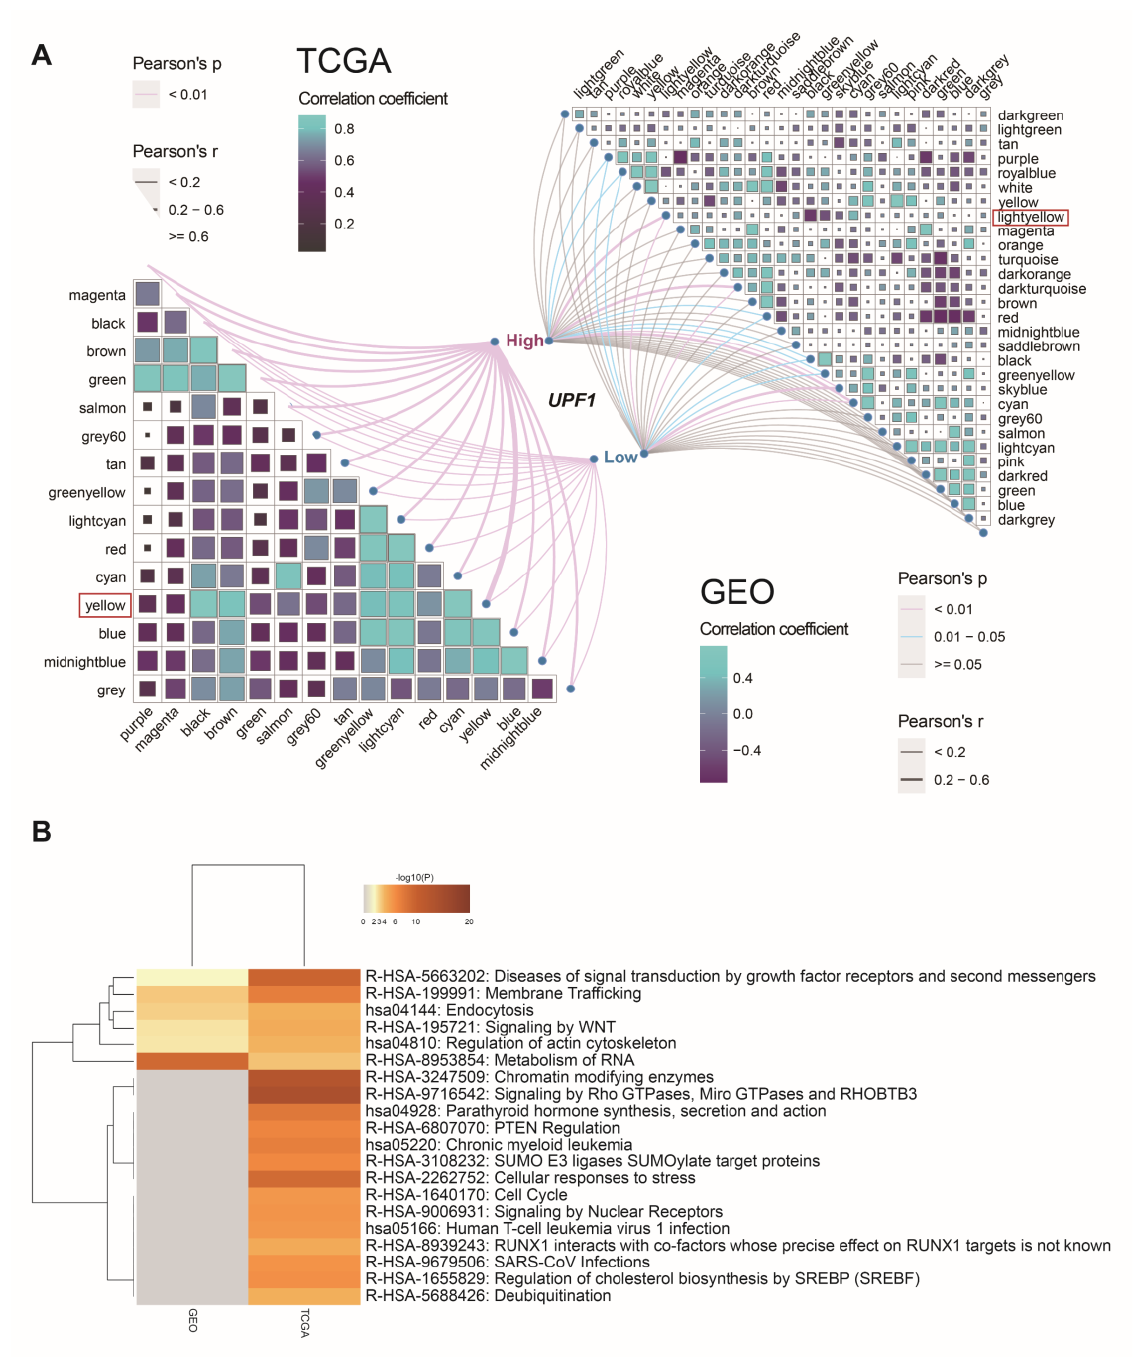
Figure 5. Identification of co-expression genes based on UPF1 expression status. ( A ) Weighted co-expression networks based on UPF1 expression-based groups (the right part: GEO database; the left part: TCGA database). ( B ) KEGG and Reactome pathway enrichment analyses between key modules in TCGA and GEO cohorts.